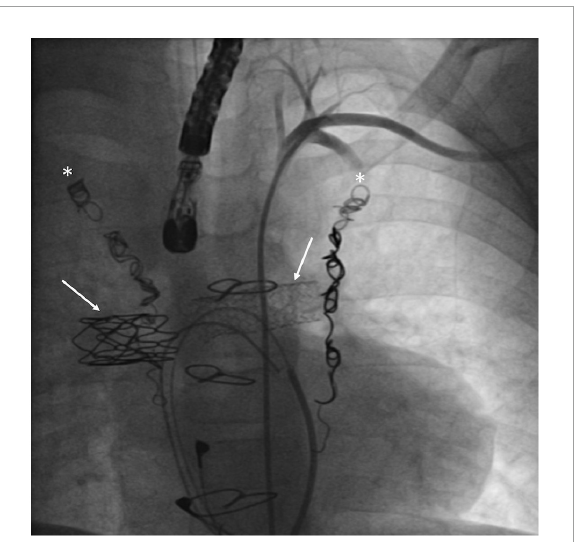
FIGURE2 Patient with a Fontan failure who underwent coil embolization of both mam-mary arteries (white asterisks) and stenting of right and left pulmonary arteries (with